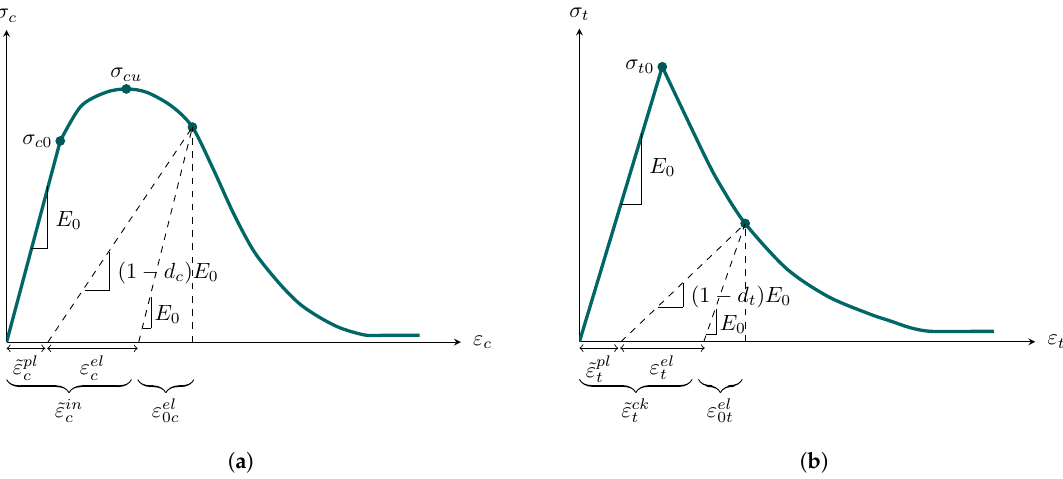
Figure 7. CDP modeling technique for uniaxial stress–strain relationship of semi-brittle materials: ( a ) under compression and ( b ) under